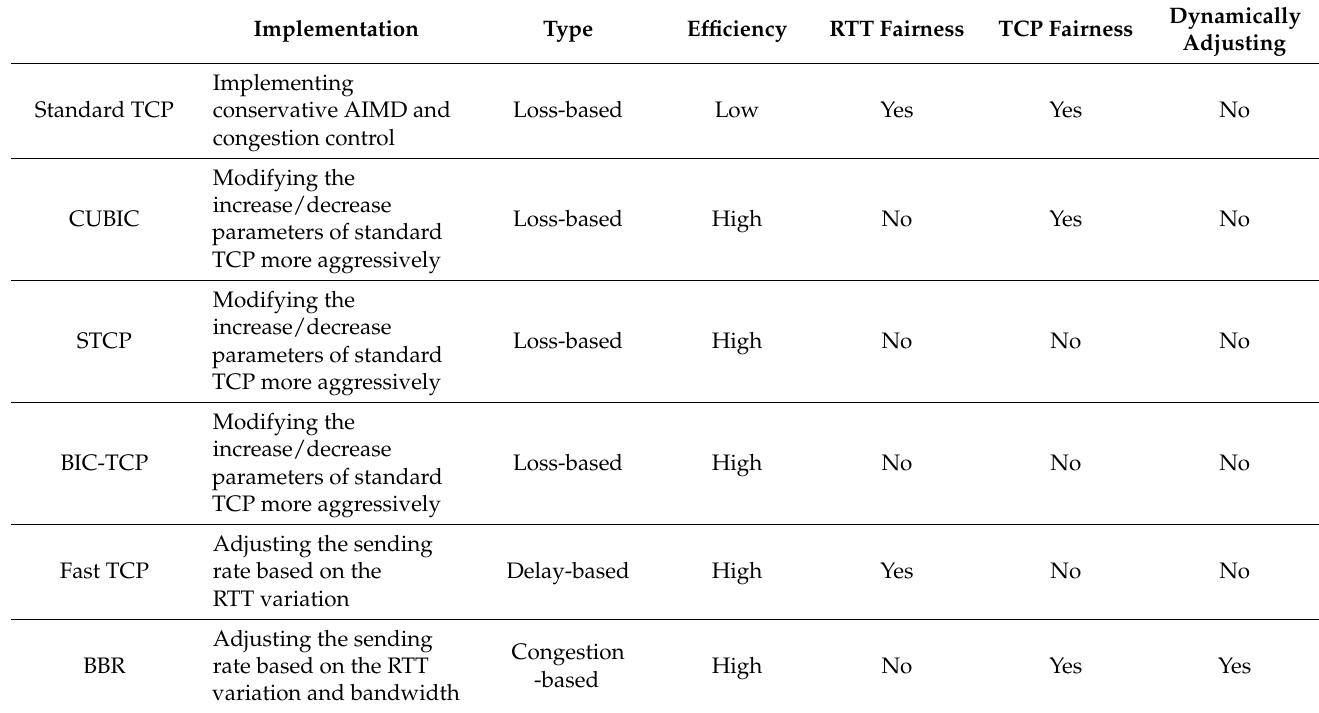
Table 1. Comparison of single path TCP